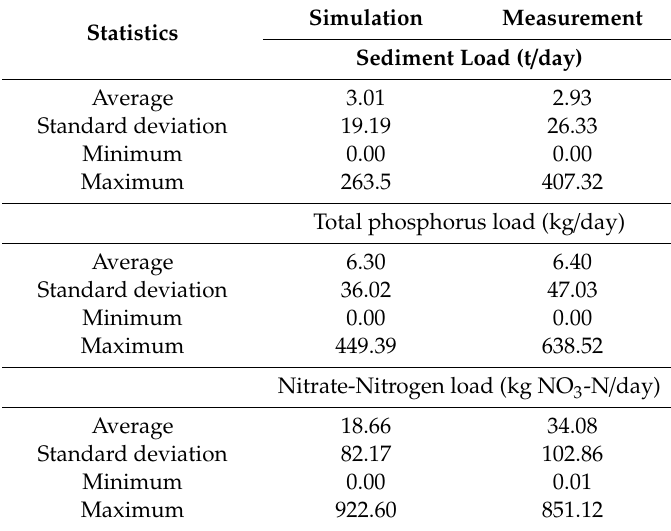
Table 8. Comparison of the average daily value, standard deviation, minimum and maximum sediment loads, total phosphorus, and nitrate nitrogen between measured and simulated values after calibration of the base model (2008–2009) at the Kožbanjšˇcek stream main outflow.